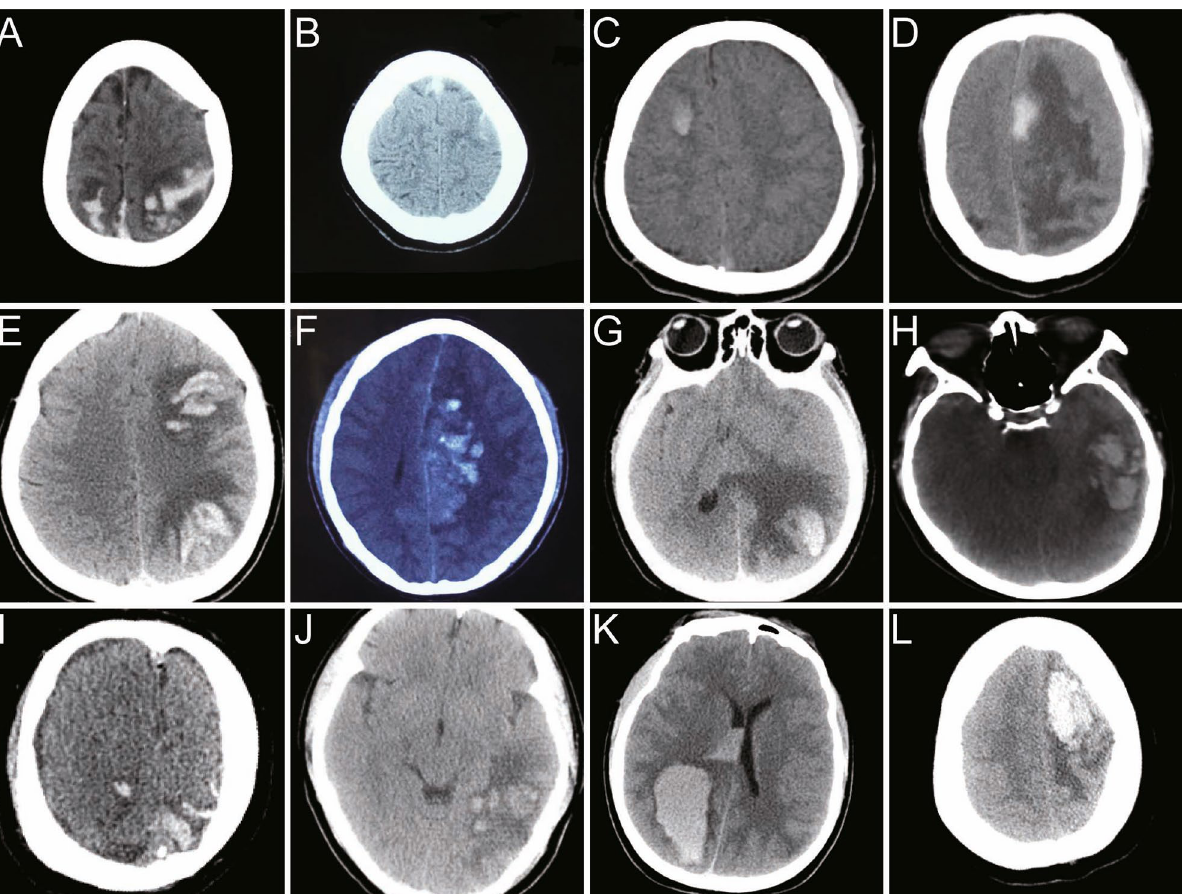
Figure 2. Serial common hemorrhagic neuroimaging findings of CVST